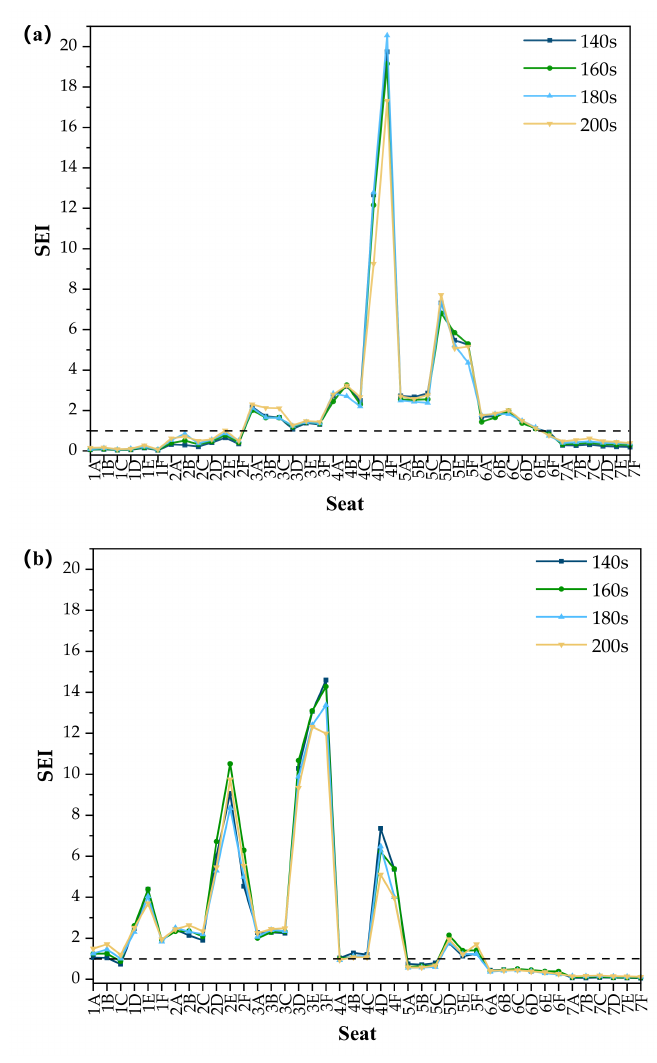
Figure 5. SEI results under when T = 140 s, 160 s, 180 s and 200 s: ( a ) normal breath; ( b )